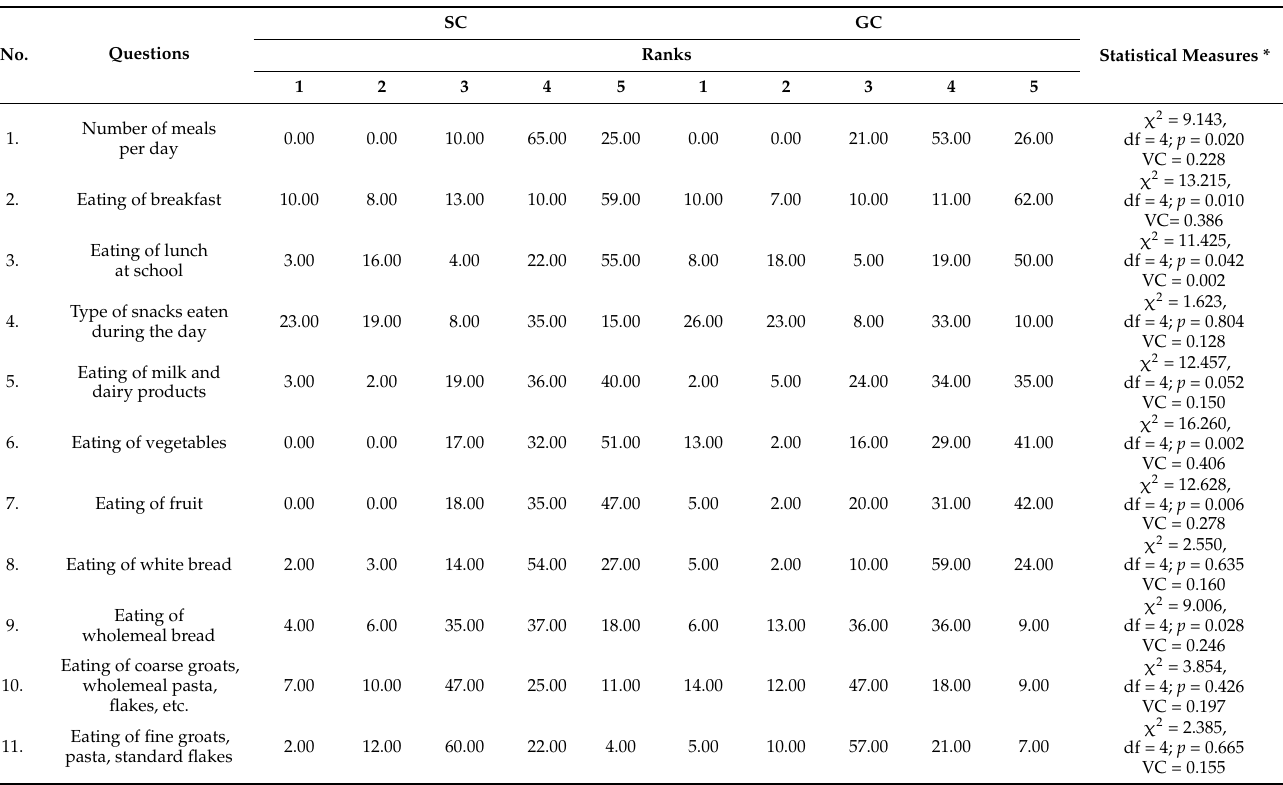
Table 4. Eating behaviour of children in the final assessment session (2019), % of particular ranks in the